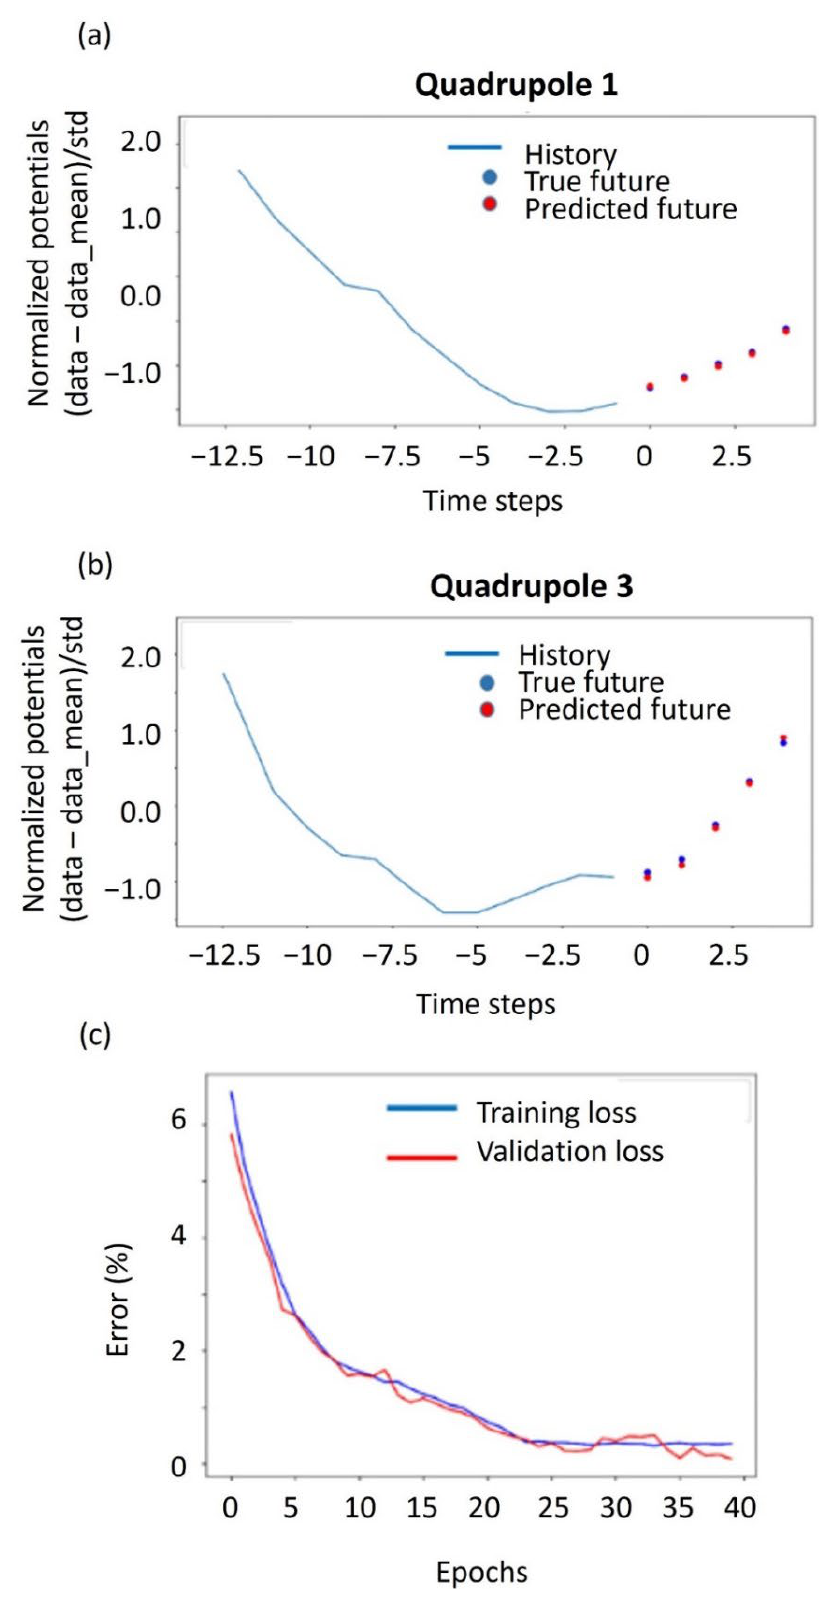
Figure 7. ( a , b ) Examples of RNN’s predictions (normalized electrical potentials vs. time); ( c ) Loss function convergence trend (bottom-right panel). The training dataset consists of 13 time steps.